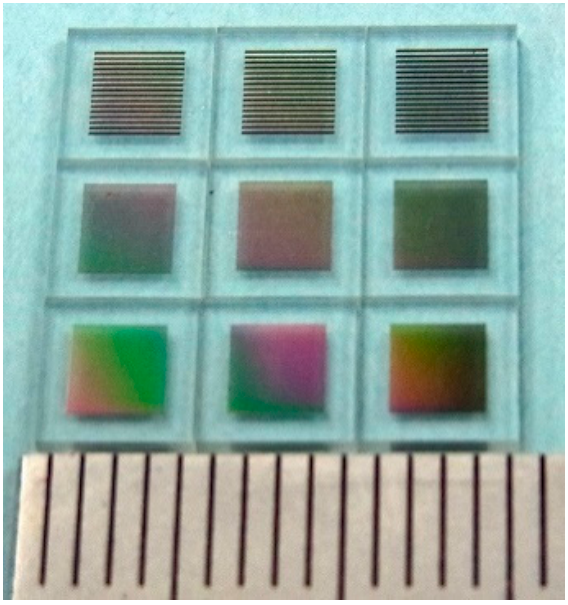
Figure 7. View of the fabricated many-body elements.